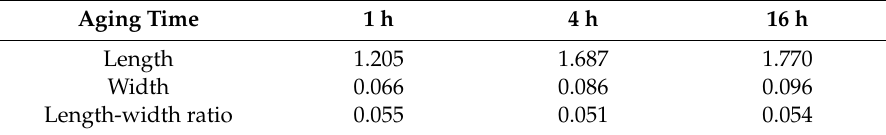
Table 3. The relation between the size of the δ phase and the aging time (unit: µ m).